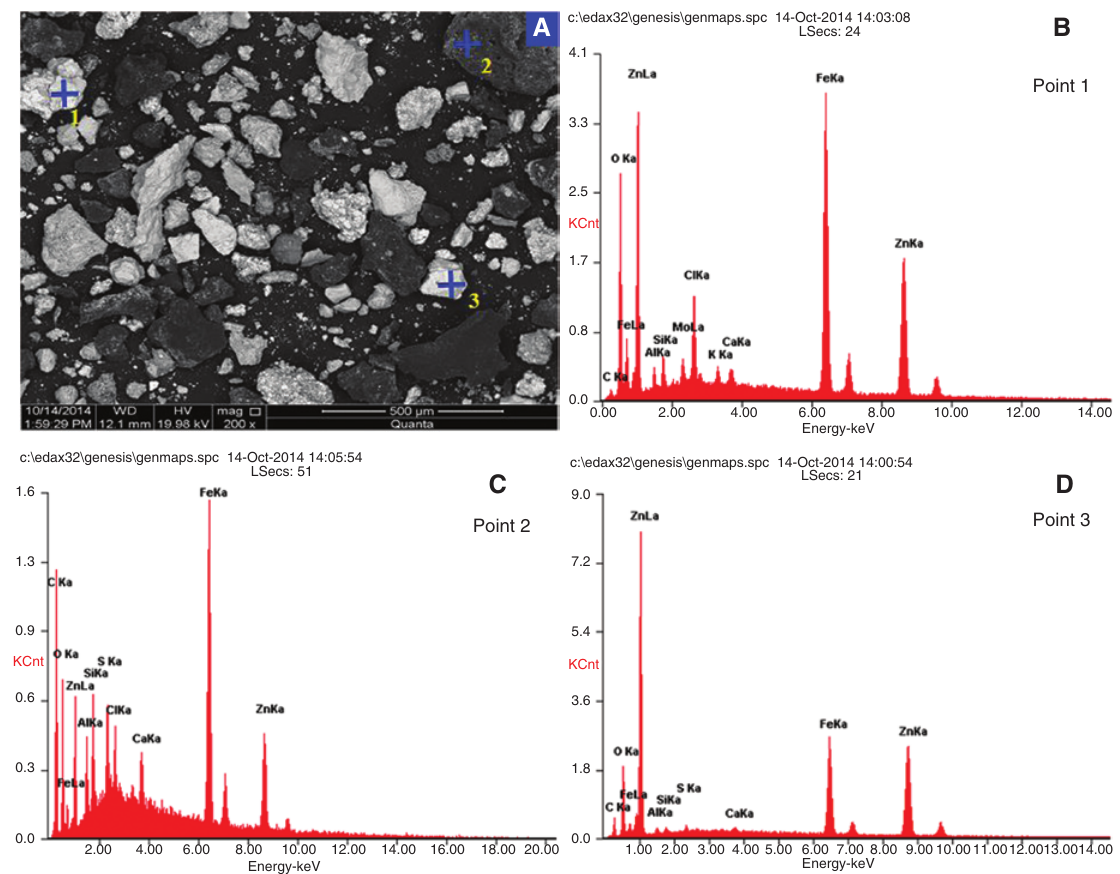
Figure 2: Scanning electron microscope (SEM) and energy dispersive analysis (EDS) pattern of the blast furnace